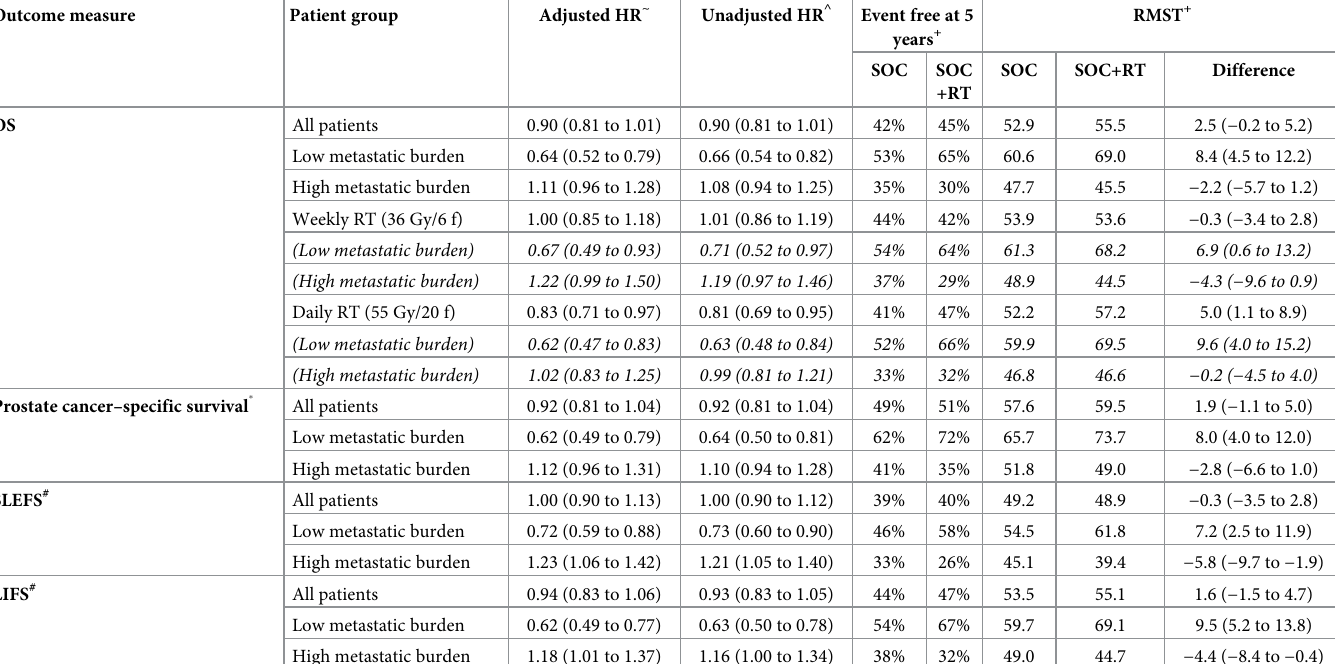
Table 2. Summary of estimated treatment effect for main outcome measures: all patients and metastatic burden subgroups. Outcome